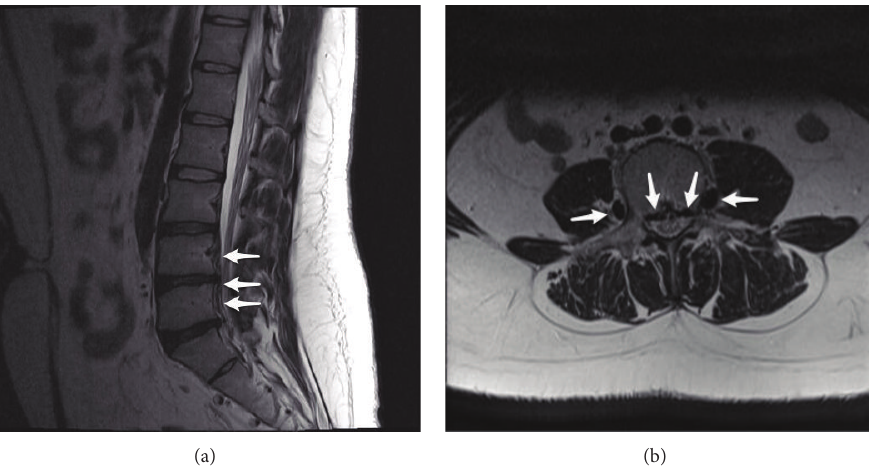
Figure 1: Sagittal T2-weighted image shows vascular enlargement in the epidural area at the level of lower lumbar vertebrae (a). Axial T2- weighted image shows the epidural veins obliterating the epidural space and engorgement of the ascending lumbar vein (b).